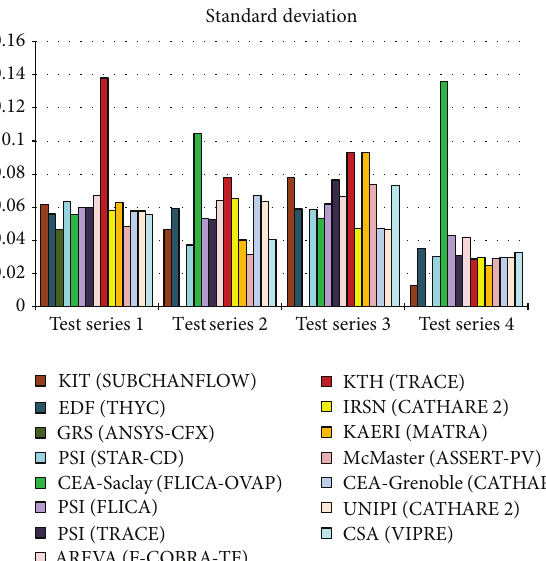
Figure 20: Deviation of measured quality from recalculated quality for test series 8.